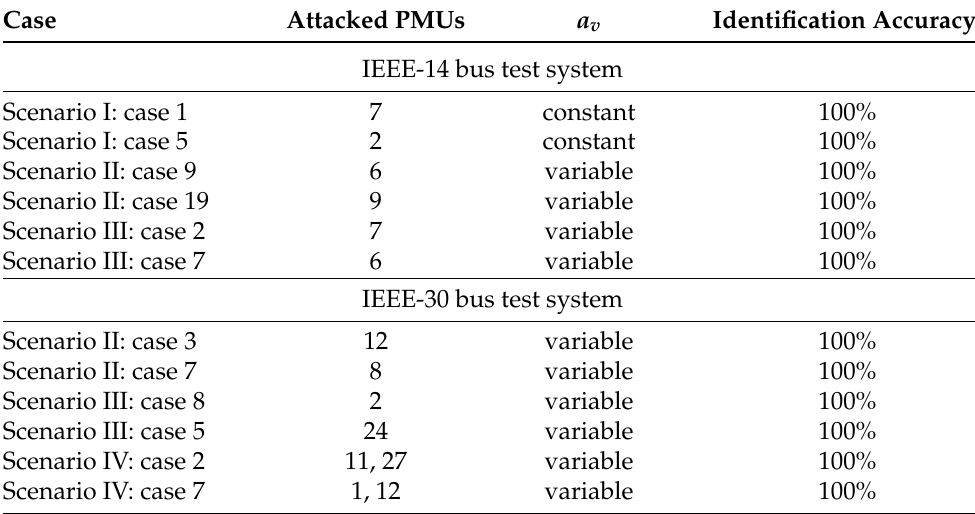
Table 4. Performance of detecting location of Attacked PMUs.